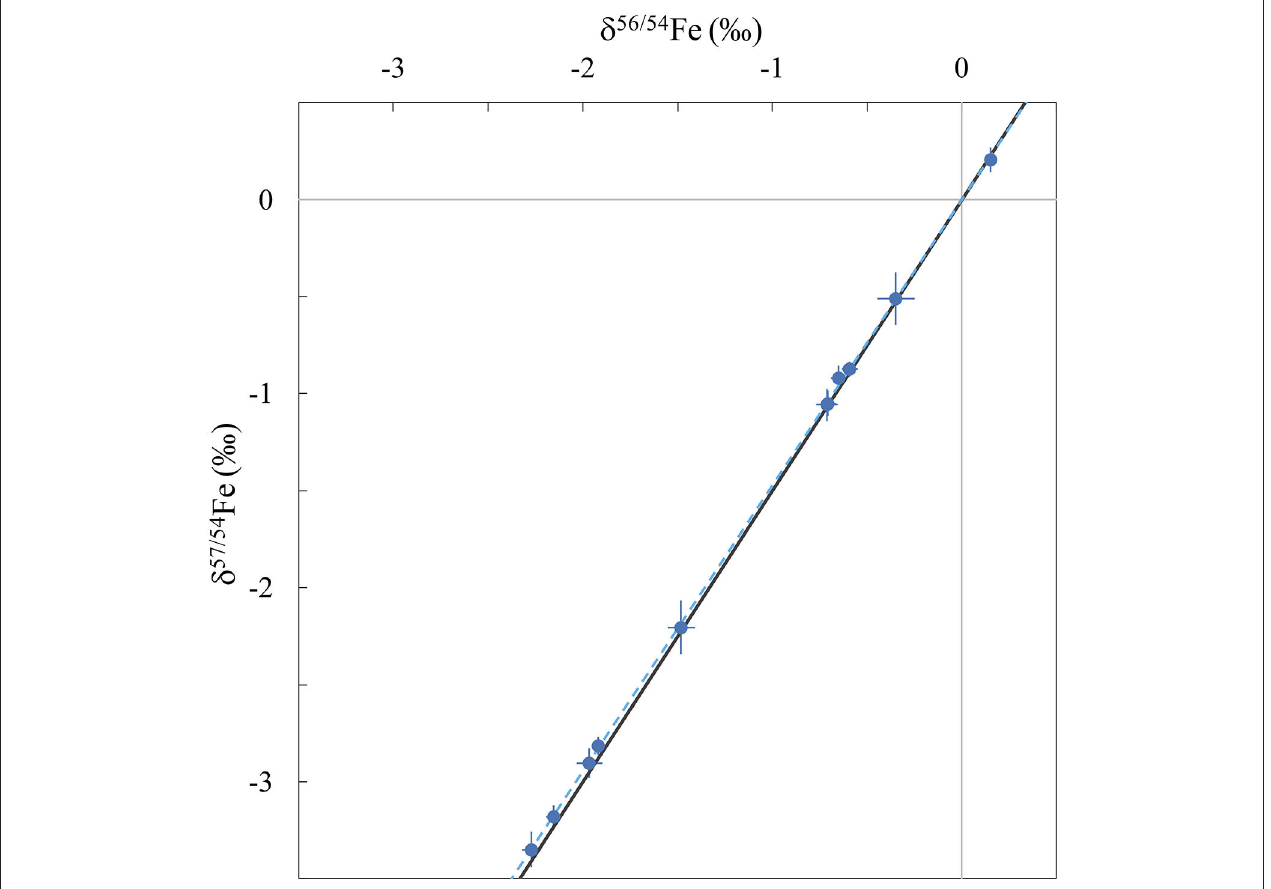
FIGURE 1 | Three-isotope diagram showing δ 57 Fe vs. δ 56 Fe for all samples measured in this study (blue symbols) with 2s.e. error bars. The blue dotted line corresponds to the regression fit calculated from the dataset and the black line is the theoretical mass-dependent fractionation